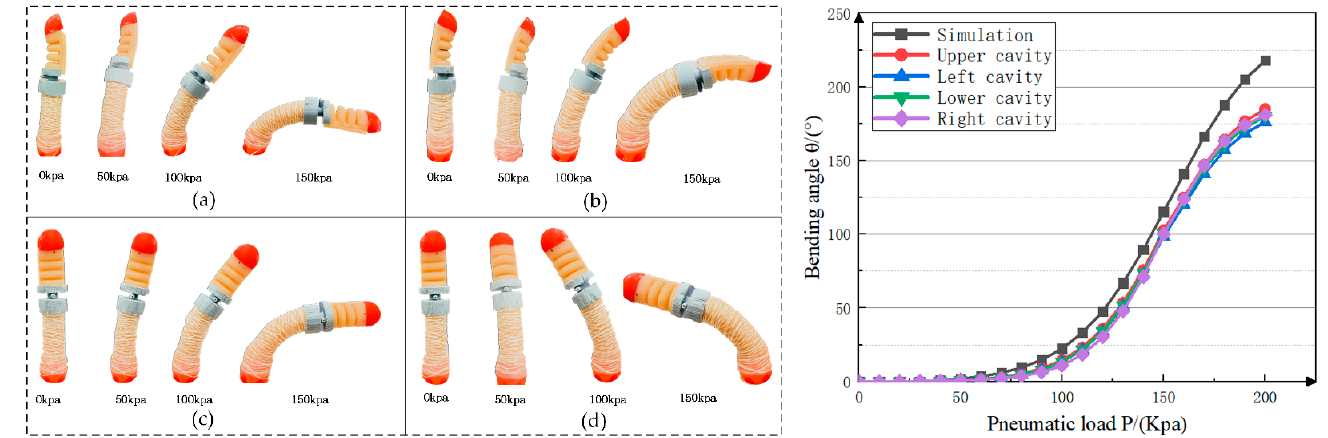
Figure 12. GUI control interface.